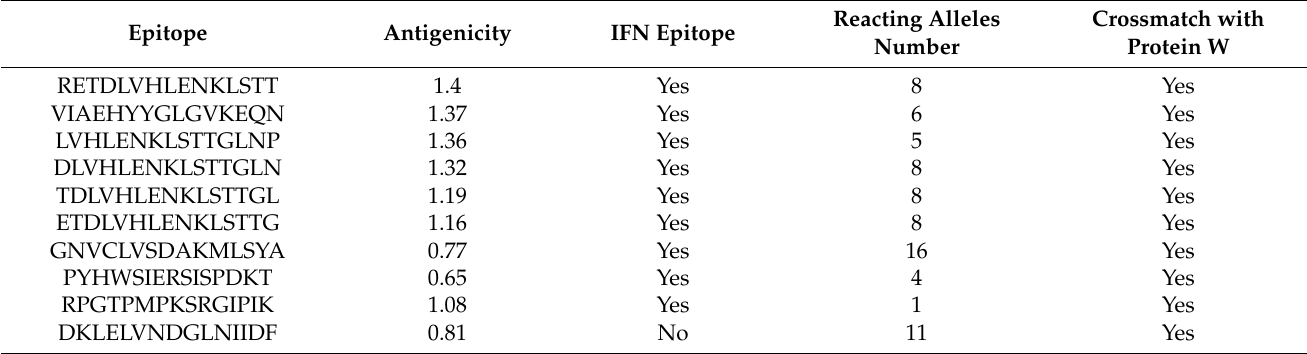
Table 6. Top-ranked T cell epitopes (MHC-II peptides) of V protein.